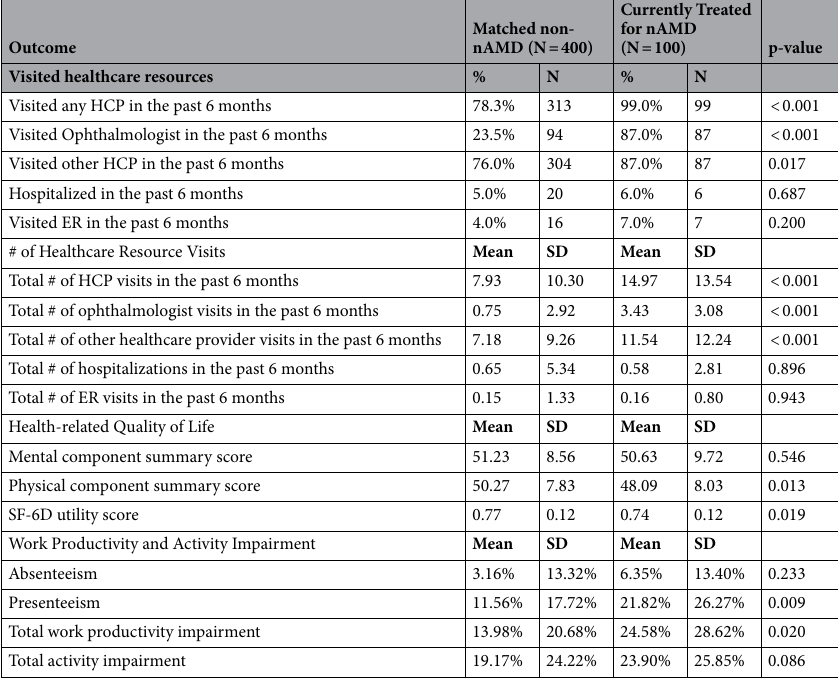
Matched non-nAMD (N = 400)